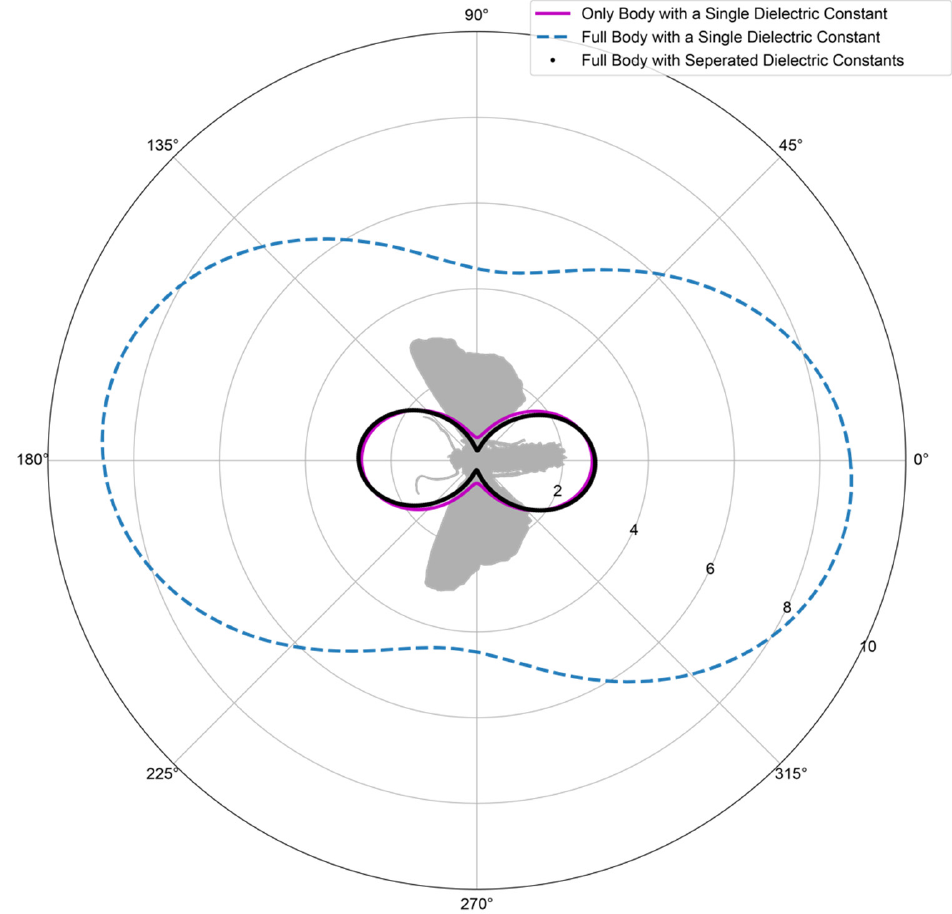
Figure 13. Comparison of the modelled polarimetric RCSs (cm 2 ) showing the combined differences between morphology (Full and Body Only models), and composition with the body, wings, and legs and antennae having individual or identical material/dielectric constants. The shadowed model is not to scale and for orientation purposes